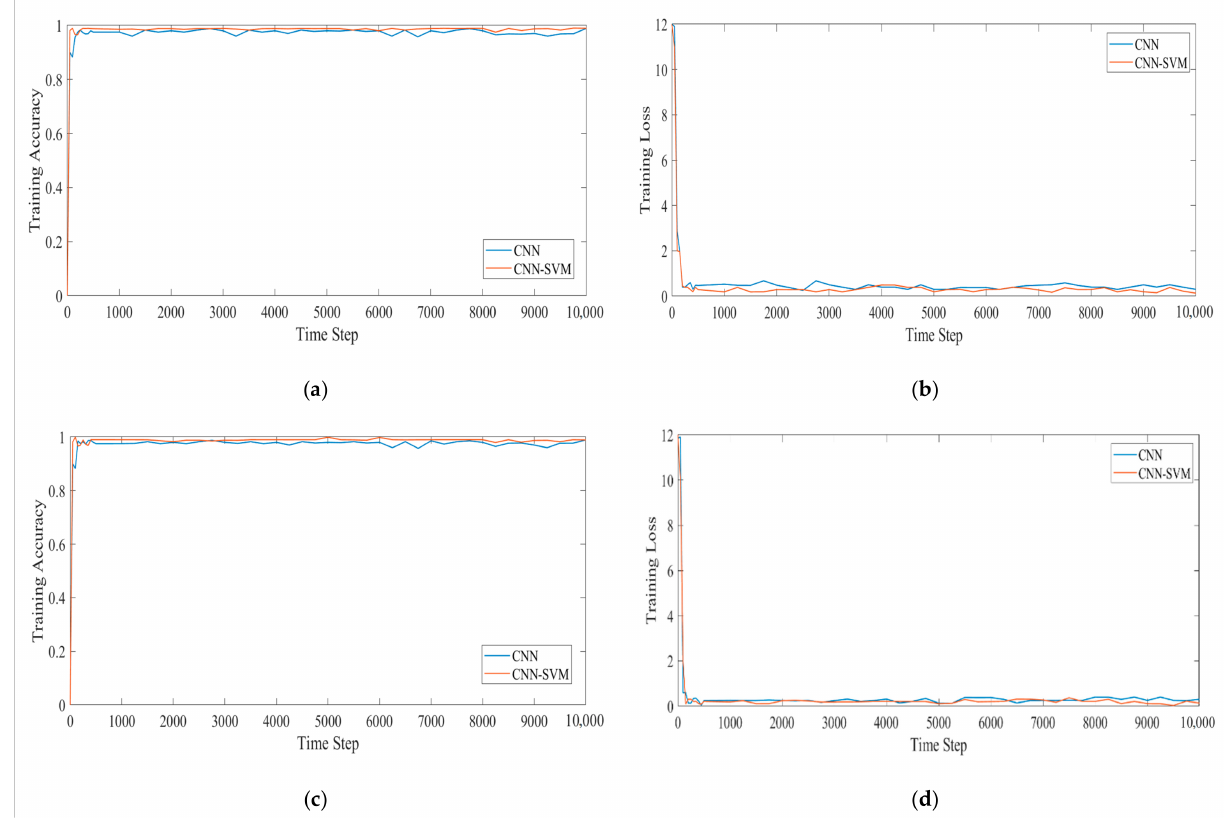
Figure 21. ( a ) Training accuracy of CNN and CNN-SVM on image classification using the HE dataset; ( b ) training loss of CNN and CNN-SVM on image classification using the HE dataset; ( c ) training accuracy of CNN and CNN-SVM on image classification using the AHE dataset; ( d ) training loss of CNN and CNN-SVM on image classification using the HE dataset.